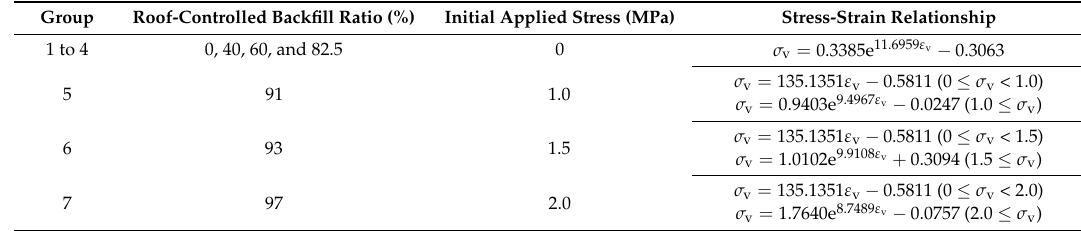
Table 3. Stress-strain relationships under different backfill